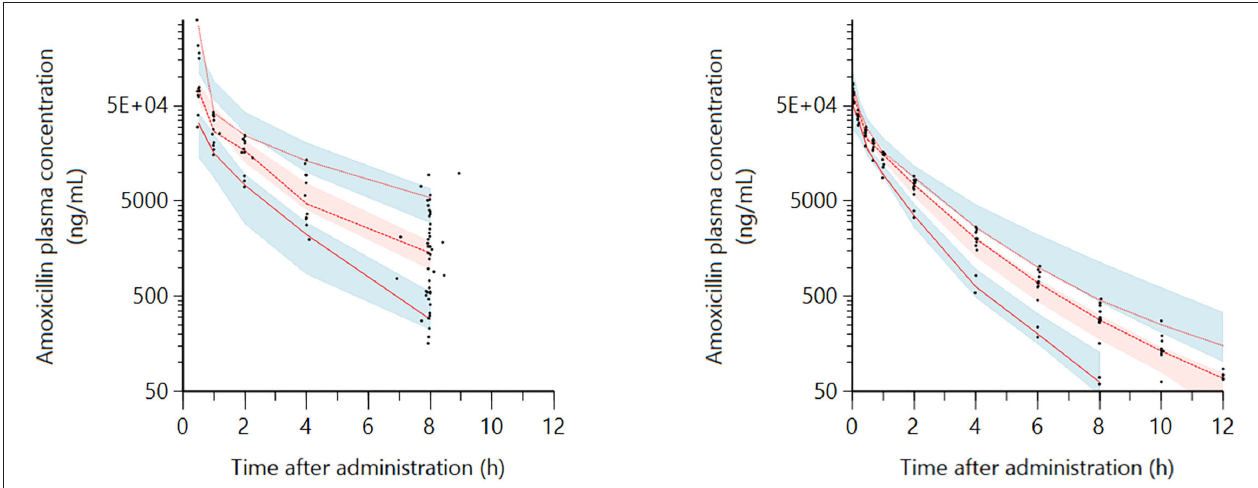
FIGURE 2 | Visual Predictive Check (VPC) for the intravenous (IV) route obtained with 300 replicates of each animal in the dataset (sick dogs on the left plot and healthy dogs on the right plot). Red lines: observed quantiles (10th, 50th, and 90th). Black symbols: observed amoxicillin plasma concentration data (ng/mL). Blue and red shaded areas: the 90% confidence interval of predicted quantiles (10th, 50th, and 90th). The observed quantiles (10th, 50th, and 90th) are rather well-superimposed with the corresponding predictive check quantiles over the observed data. Theoretically, about 20% of data should be outside the plotted